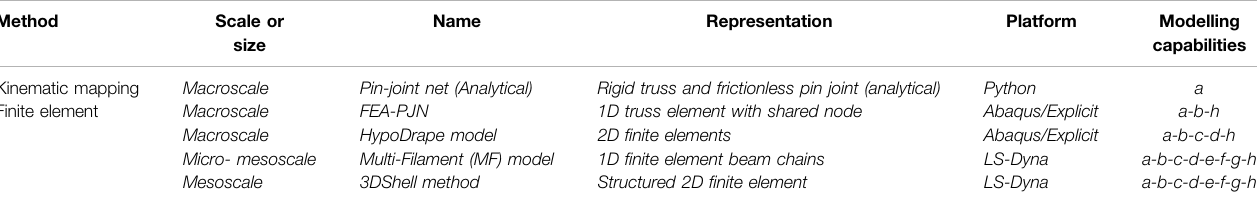
TABLE 1 | Attributes of all modelling approaches selected for comparison. (letters under “ Modelling capabilities ” refer to list shown in